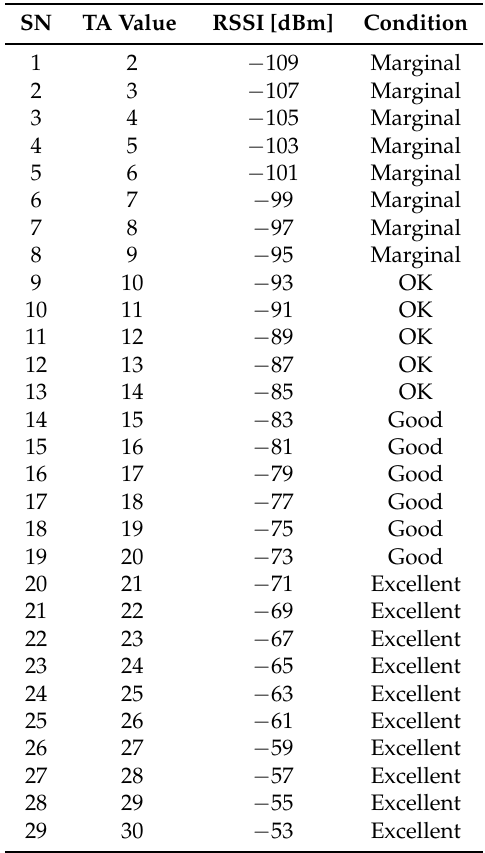
Table 3. Mapping between TA value and RSS in